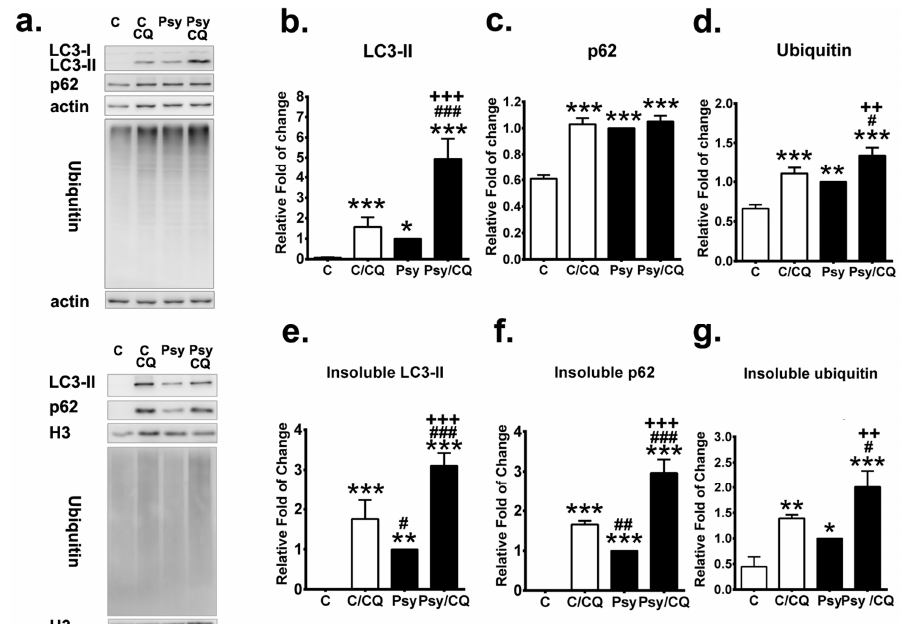
Figure 8. Autophagy inhibition increases accumulation of insoluble p62 and ubiquitin. ( a ) Western blot analysis of the total LC3-II, p62, and ubiquitin in MO3.13 cells treated without (control: C) / with psychosine (Psy) for 72 h concomitant with / without chloroquine (CQ) for the last 24 h. Soluble and insoluble fractions were analyzed. β -actin (actin) and histon-H3 (H3) were used for the loading control in soluble and insoluble fractions, respectively. ( b – d ) Quantification of soluble LC3-II ( b ), p62 ( c ), and ubiquitin ( d ). ( e – g ) Quantification of insoluble LC3-II ( e ), p62 ( f ), and ubiquitin ( g ). Values are expressed as mean ± S.D. ( n = 3). Statistical significance * p < 0.05, ** p < 0.01, *** p < 0.001 in comparison to control (C). C / CQ vs. Psy, or Psy / CQ, # p < 0.05, ## p < 0.01, ### p < 0.001. Psy vs. Psy / CQ, ++ p < 0.01, +++ p < 0.001.